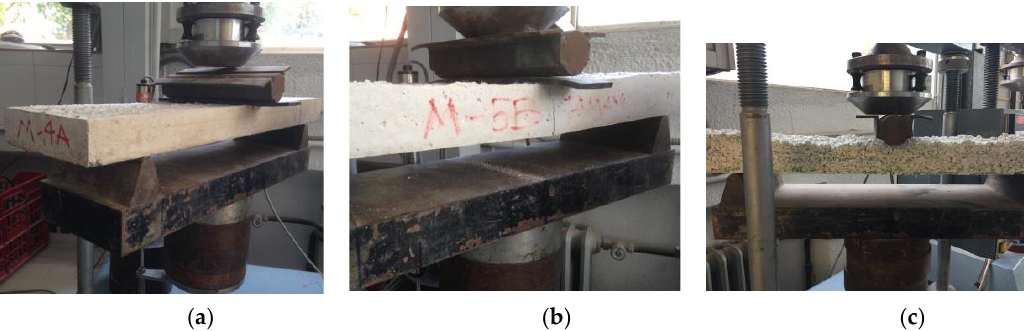
Figure 8. Specimens subjected to bending tests. ( a ) recommended proportion; ( b ) double proportion; ( c ) triple proportion.